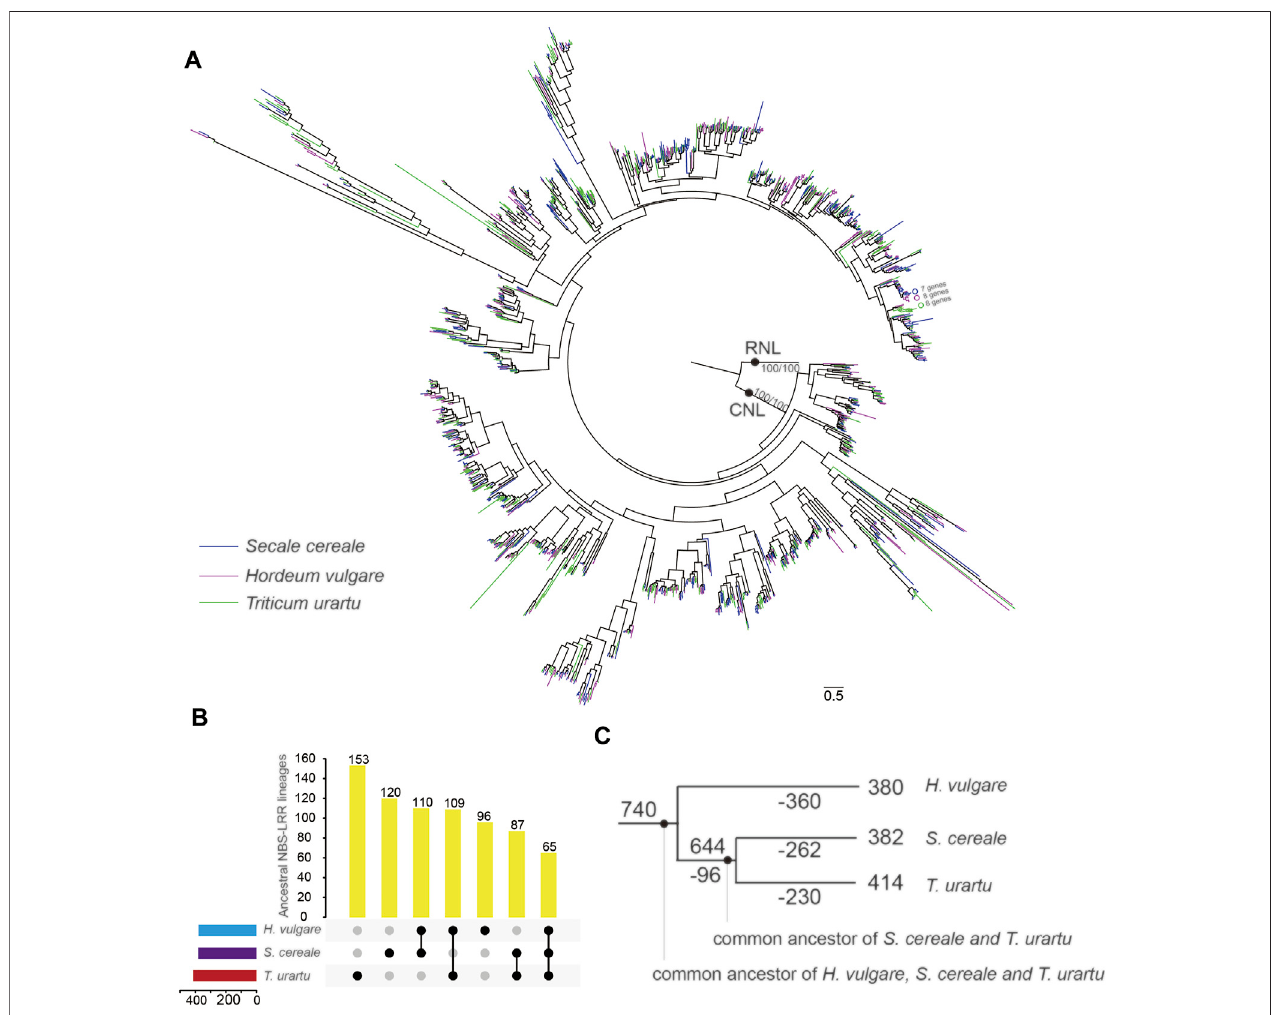
FIGURE 5 | Phylogenetic and evolutionary analysis ofNBS-LRR genes in S. cereale . (A) A phylogeny for NBS-LRR genes from S. cereale , H. vulgare and T. urartu constructed based on the conserved NBS domain. Branch support values obtained from SH-aLRT (%) and UFBoot2 (%) are labeled on basal nodes. (B) Distribution of ancestralNBS-LRRlineagesamongthethreespecies. (C) Thedifferentialinheritanceof740predictedancestralNBS-LRRlineagesduringspeciesspeciation.Ancestral NBS-LRR lineage numbers on each node/branch are indicated. Numbers of lineage loss events are indicated by numbers with ‘ - ’ on each node/branch.